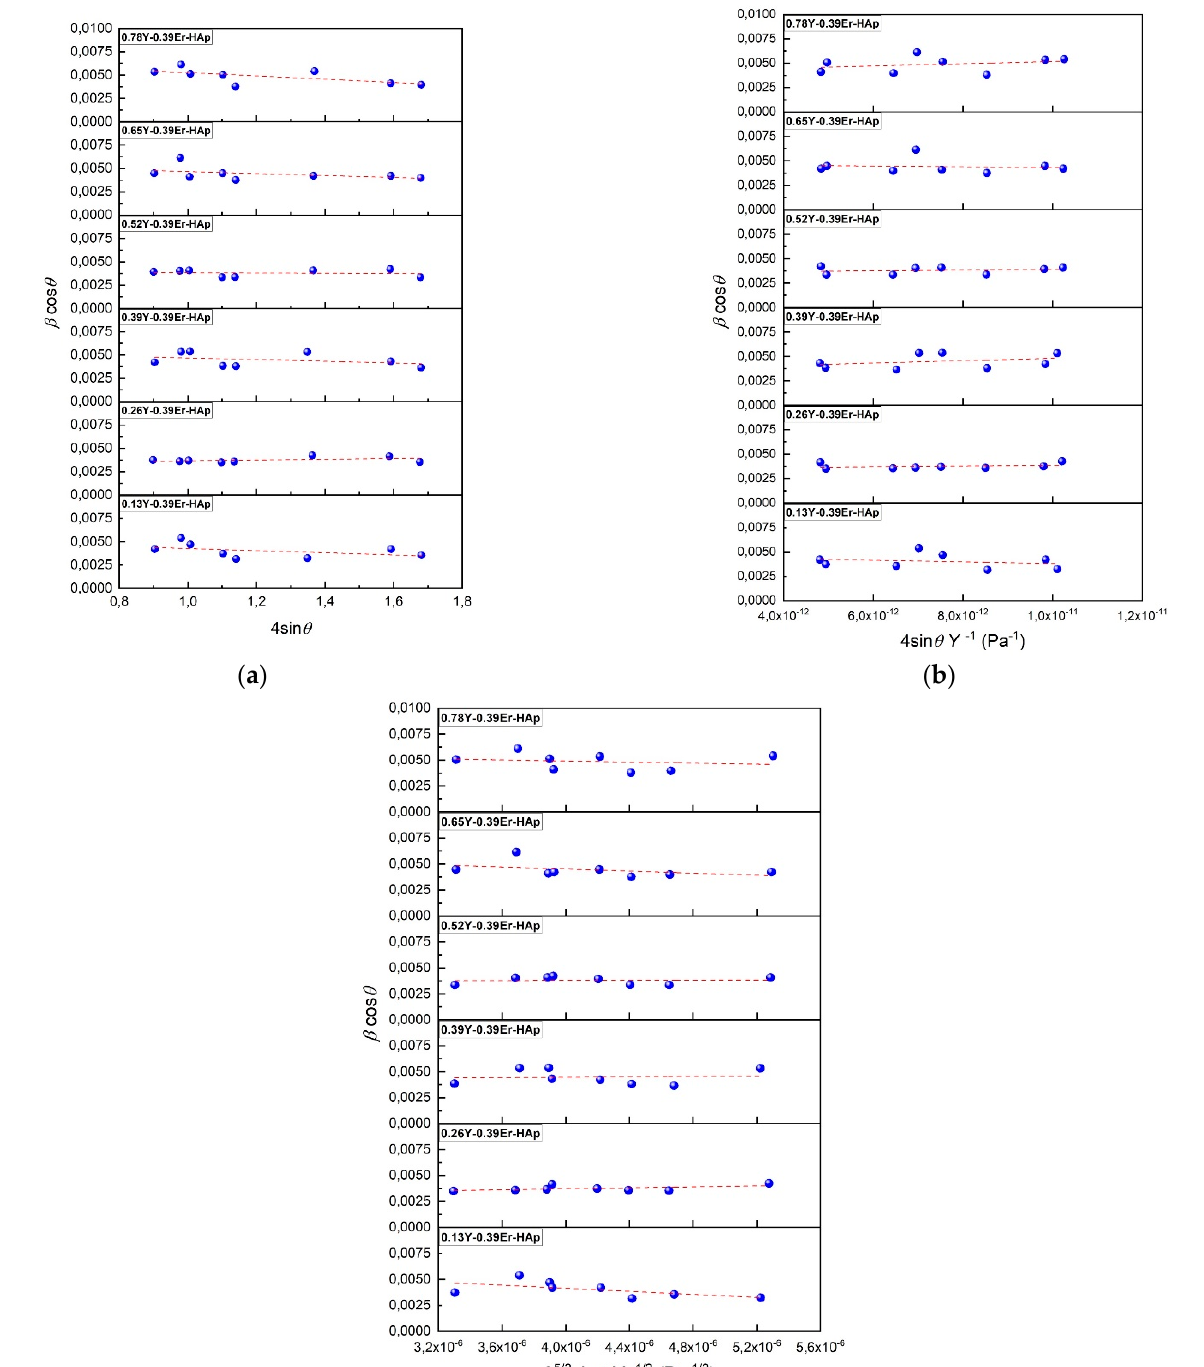
Figure 2. ( a ) The β cos θ vs. 4 sin θ , ( b ) β cos θ vs. 4 sin θ E − 1 , and ( c ) β cos θ vs. 2 5/2 sin θ E − 1/2 plots of the Er-based HAps doped with